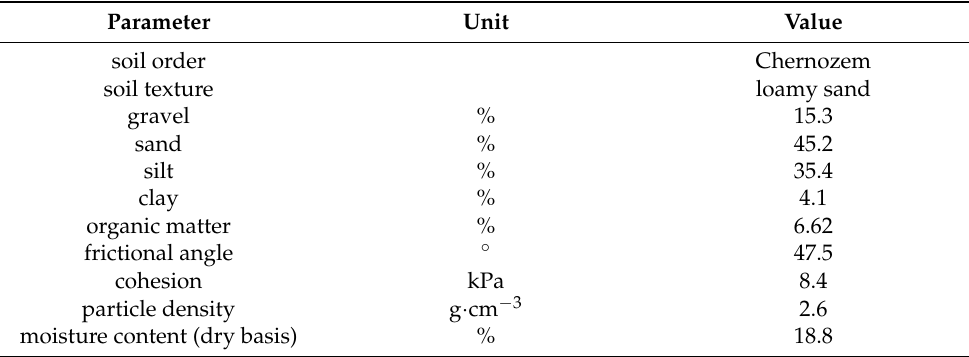
Table 1. Soil properties of the experimental area.